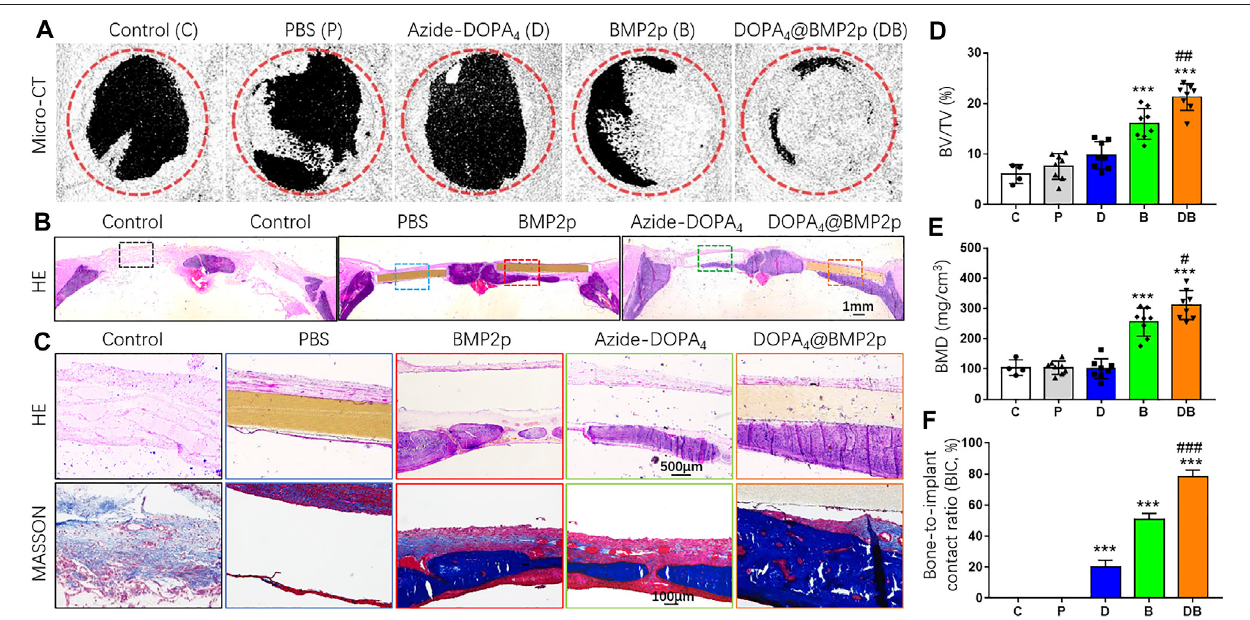
FIGURE 5 | In vivo bone defect repairing effects of PEEK after different surface modi fi cations. (A) Micro-CT 3D-reconstructed images and (D,E) quantitatively evaluating the peri-implant bone generation according to the percentage bone volume (BV) among tissuevolume(TV) (BV/TV) and bone mineral density (BMD). (B) H&E histological section staining images of the in vivo osseointegration of different surface-modi fi ed PEEK implants at low magni fi cation and (C) high magni fi cation. (D) Masson ’ s staining images of the different surface-modi fi ed PEEK implants. (G) Histomorphometric analysis of bone-implant contact (BIC) percentage of different surface-modi fi ed PEEK implants. Data are presented as the mean ± SD, n (cid:2) 4 – 8. Statistically signi fi cant differences are indicated by *** p < 0.001 compared with the shamcontrolgroup(groupC)and # p < 0.05, ## p < 0.01,or ### p < 0.001comparedwiththeBMP2p-PEEKgroup(groupB).Abbreviations:C(control),P(PBS),D(Azide-